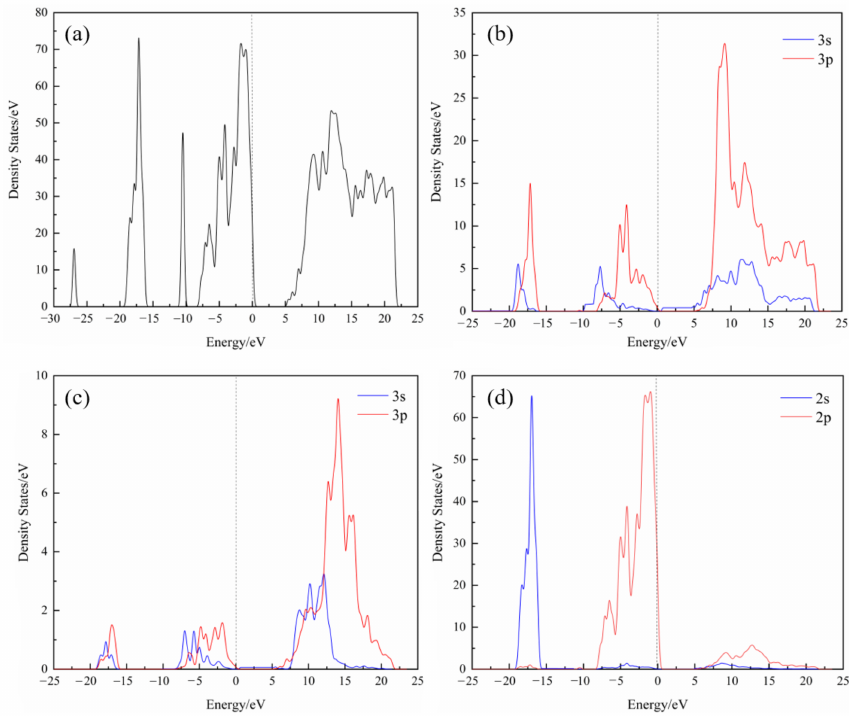
Figure 10. Muscovite state density (( a ) total state density diagram ( b ) Al state density diagram ( c ) Si state density diagram ( d ) O state density diagram).